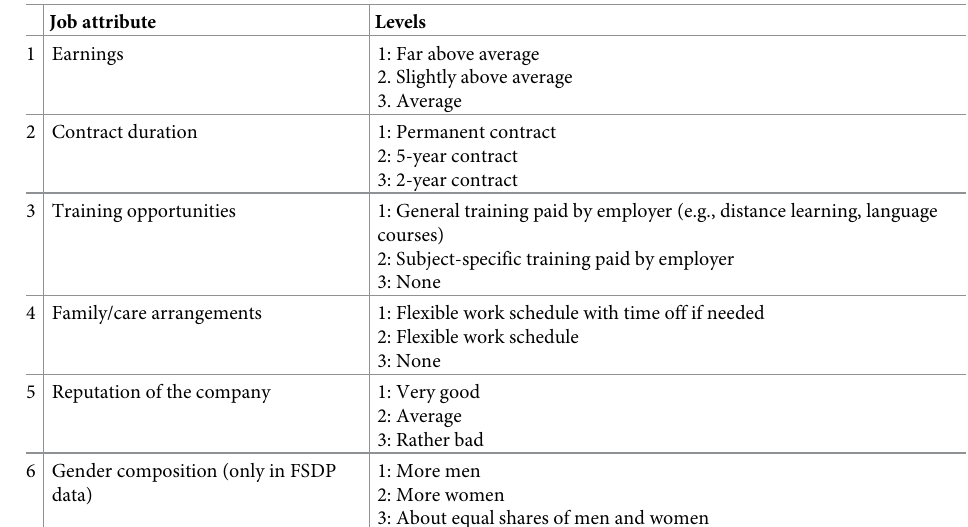
Table 2. Attributes and levels of the discrete choice